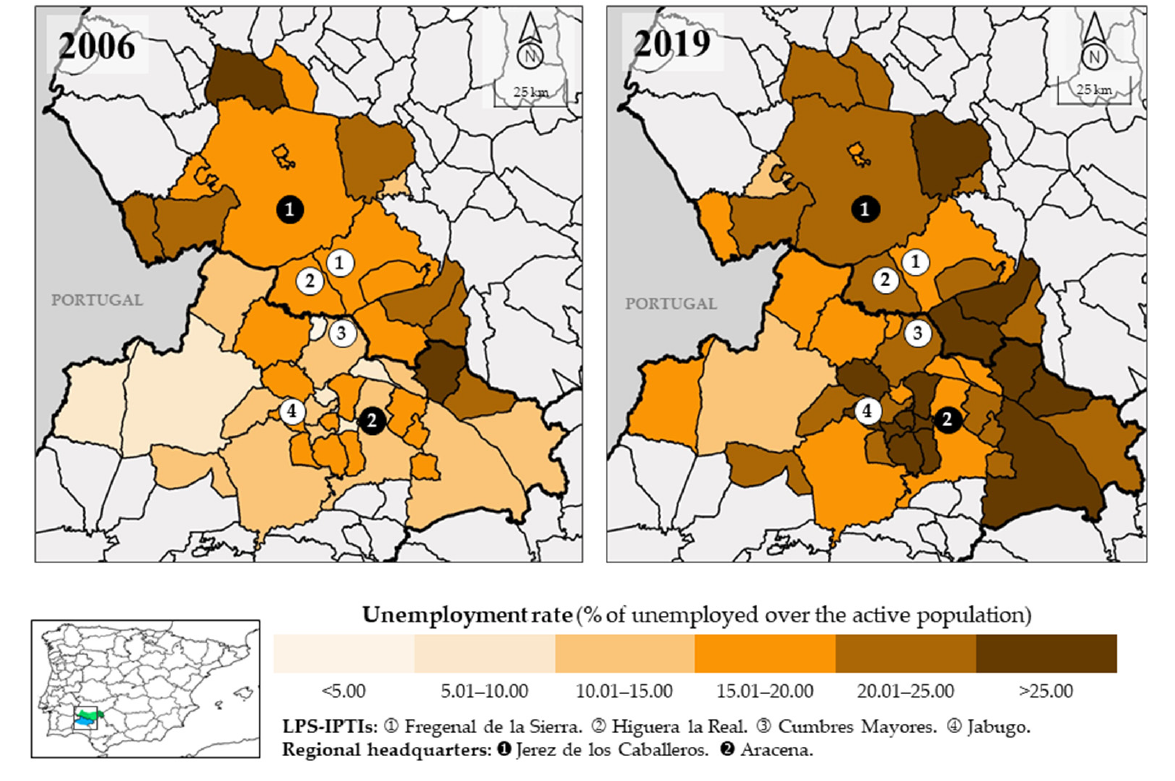
Figure 12. Unemployment rate by municipalities (2006 and 2019). Source: [102]. Authors own elaboration.